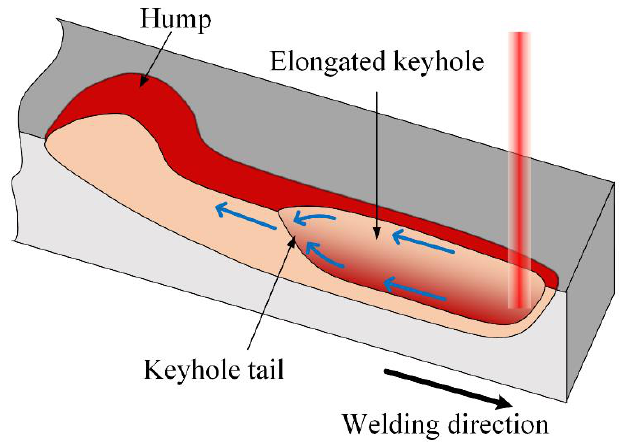
Figure 13. Appearance of the melt pool during humping formation.